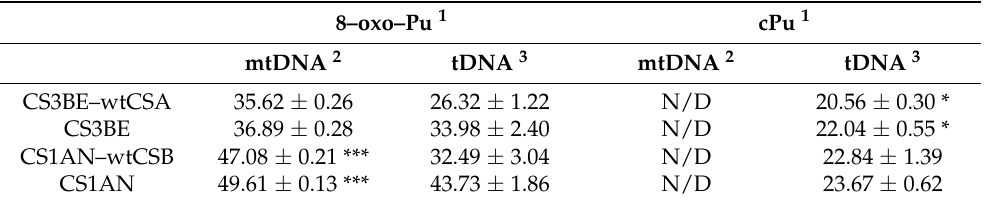
Table 2. Total amount of 8–oxo–Pu and cPu (lesions/10 7 nucleosides) in mtDNA in comparison with values of tDNA isolated from CSA and CSB (wt and defective) cells.